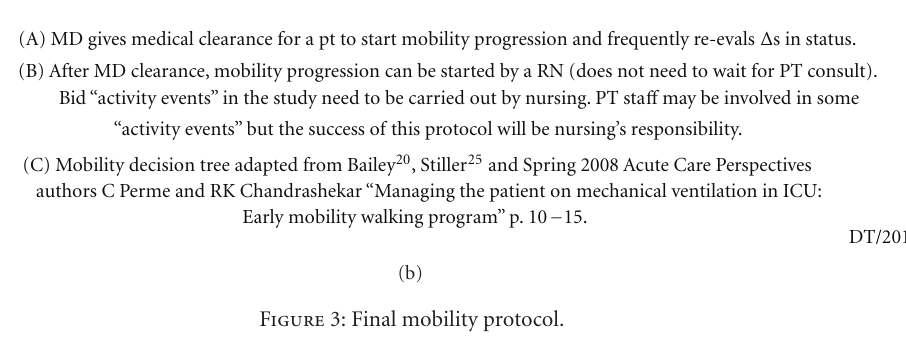
Figure 3: Final mobility